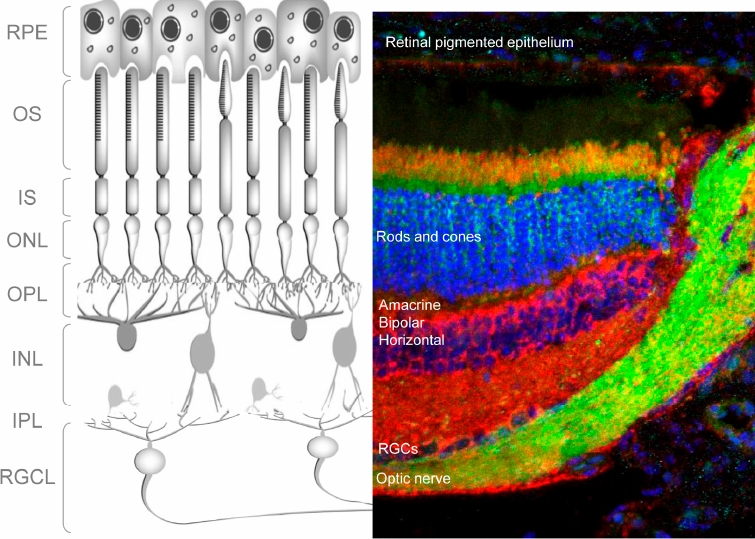
Figure 1. Morphology of the adult mouse retina. ( Left ) Schematic depicting the different cell types in the adult mouse retina; ( right ) retinal section from an adult GFP-LC3 mouse (green) stained with TOMM20 (SantaCruz Biotechnology sc-11415, in red) to assess mitochondria and DAPI (in blue) to stain nuclei.